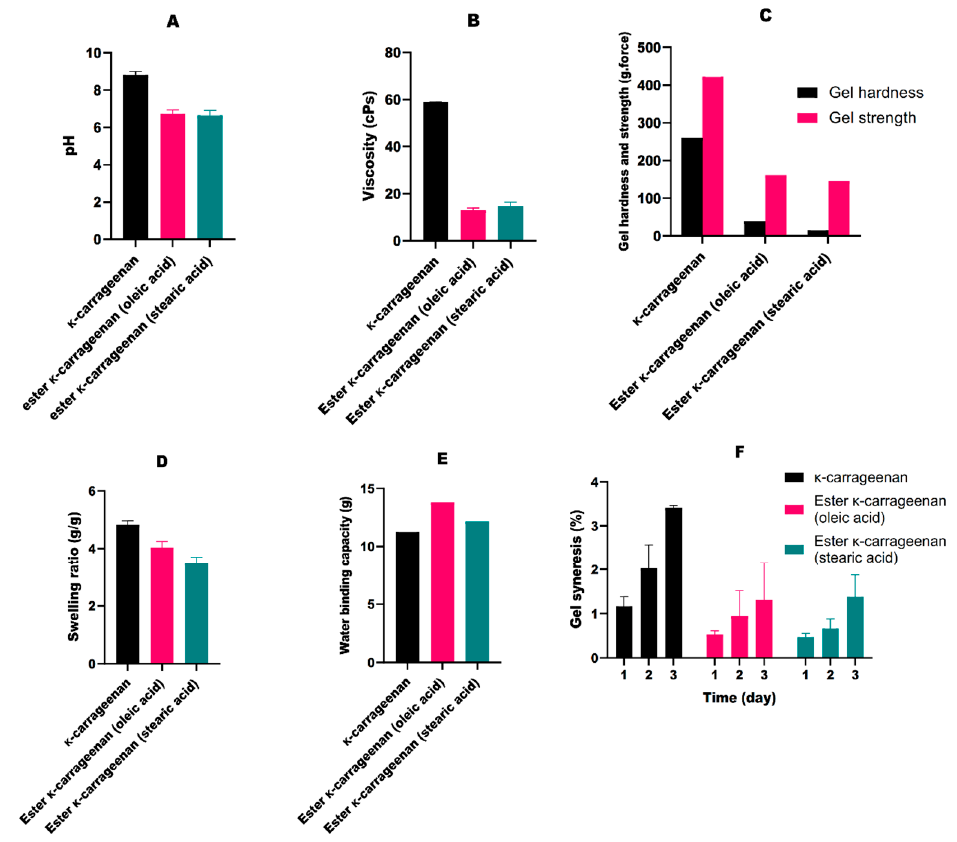
Figure 3. The pH ( A ), viscosity ( B ), gel hardness and strength ( C ), swelling ratio ( D ), water-binding capacity ( E ), and syneresis ( F ) of κ -carrageenan gel in comparison with its ester derivatives (means ± SD, n = 3).